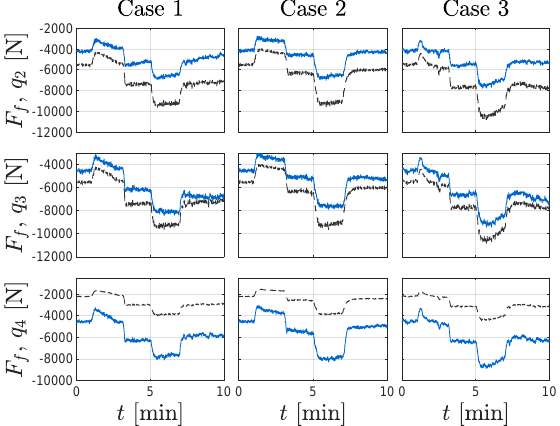
Figure 9: Case 1–3 frictional pressure forces. Solid blue lines denote the estimates and dashed black lines denote the true values.